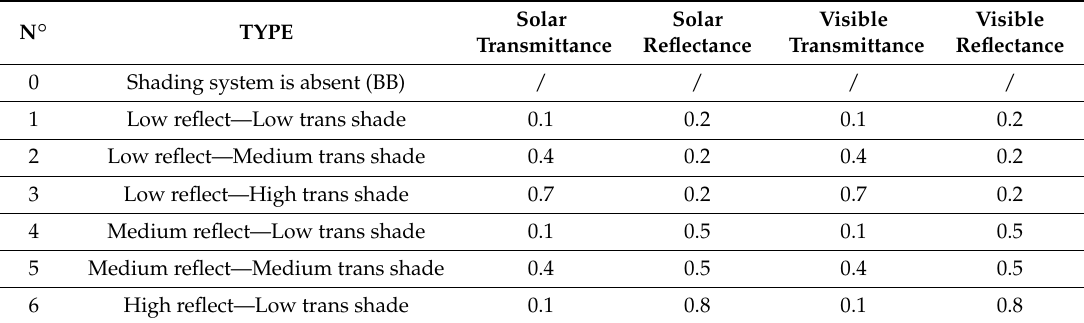
Table 8. Investigated shading systems.